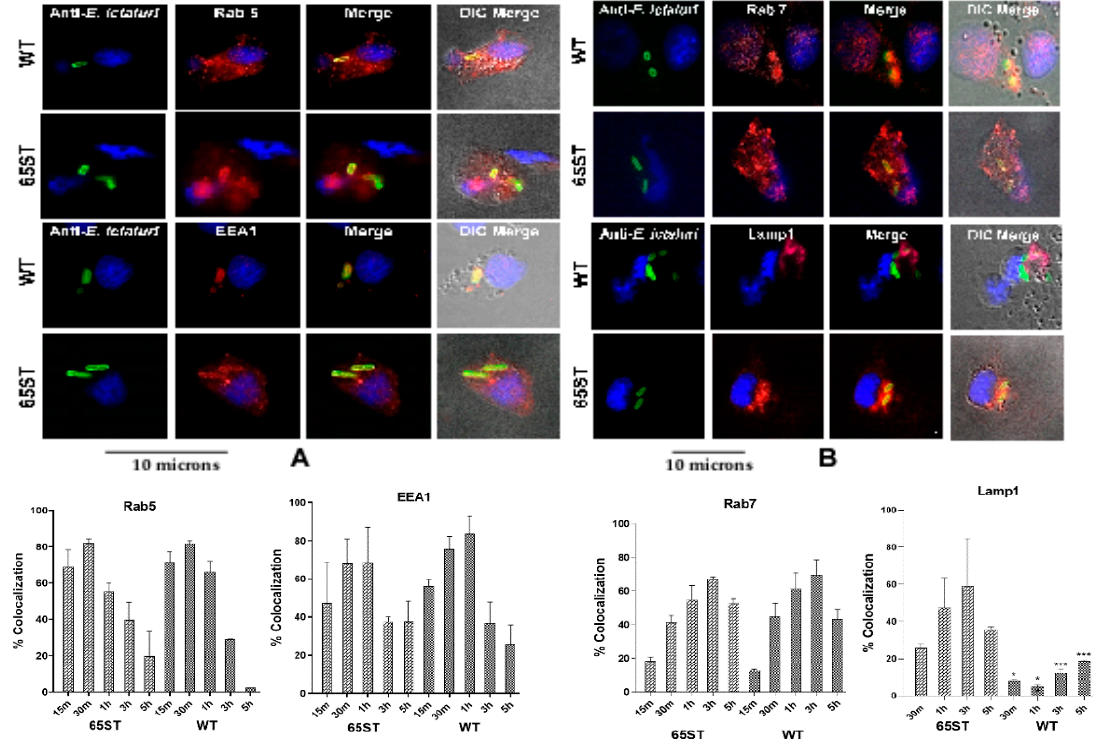
Figure 1. Immunofluorescence micrographs showing subcellular co-localization of early and late endosomal markers. WT and 65ST strains of E. ictaluri stain green. The host cell nucleus stains blue. The host cell is visible in DIC in the merged image. The graphs show the percentage of the ECV that col-localized with the given marker over time. ( A ) The early endosomal markers Rab 5 and EEA1 stain red. ( B ) The late endosomal markers Rab7 and Lamp1 also stain red. Results show that %-co-localization of the T3SS mutant 65ST and WT were not significantly di ff erent for the early endosomal markers Rab5 and EEA1, or for the late endosomal marker Rab7. Significantly lower levels of Lamp1 in the WT, however, indicate that phagosomal / lysosomal fusion did not occur for the WT. Statistical significances over time were determined using one-tailed unpaired T-test for each period. Data presented as the mean of three sets of 100 cells. Asterisks indicate significant di ff erences of the WT compared to the TT3S mutant 65 ST (* = p ≤ 0.01, *** = p ≤ 0.001). Further analysis showed that the host cell endoplasmic reticulum (ER) marker calnexin co-localized to the ECV of 65ST at a rate of 40% after 30 min and increased to around 60% at 1, 3, and 5 h (Figure 2). Calnexin co-localized to the WT vacuole at a rate of only 25% after 30 min, did not significantly change over time (Figure 2), and was significantly lower than 65ST. At the same time, the Golgi vesicle marker giantin was recruited to 10% of the WT ECV after 30 min and increased significantly to 23%, 35%, and 42% at 1, 3, and 5 h post-infection (Figure 2). Giantin co-localization was significantly greater for the WT than for 65ST, which stayed below 10% at all time